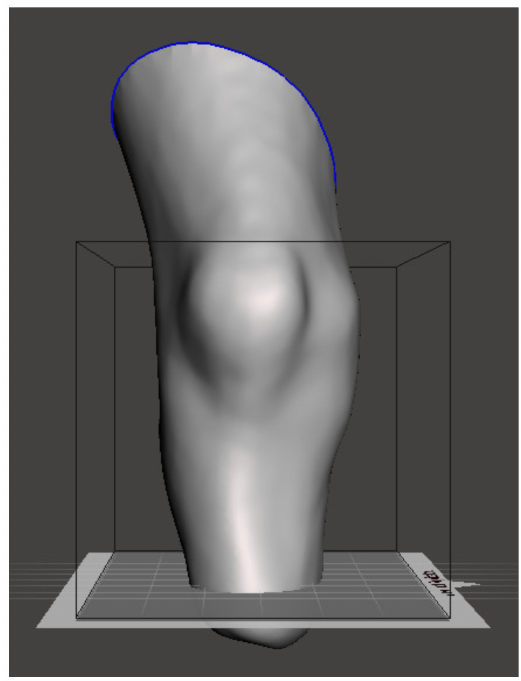
Figure 4. Visual representation of the oriented 3D